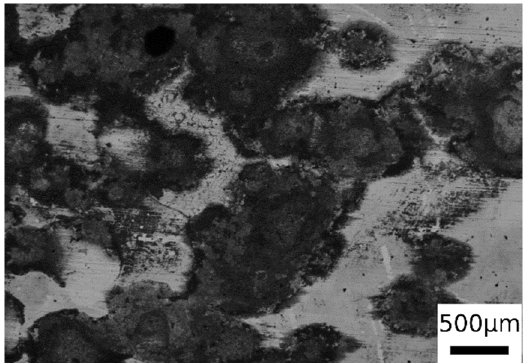
Figure 12. SEM micrographs surface of one sample after PDP tests (BSE mode) for the sample austenitized at 900 ◦ C (30 min) and austempering at 350 ◦ C for 30 min.